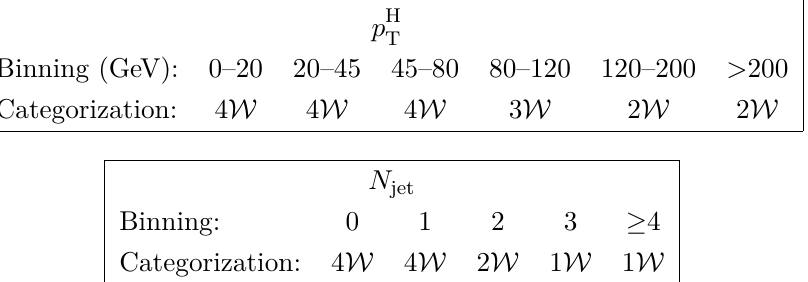
bin with its theoretical uncertainty. T